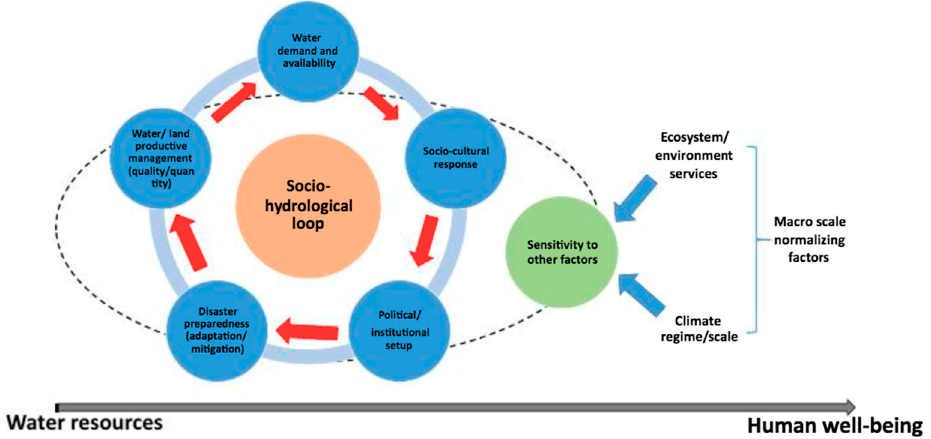
Figure 1. Conceptual diagram of socio-hydrological approach to bridge the gap between water resources and human wellbeing (Source: [6]).